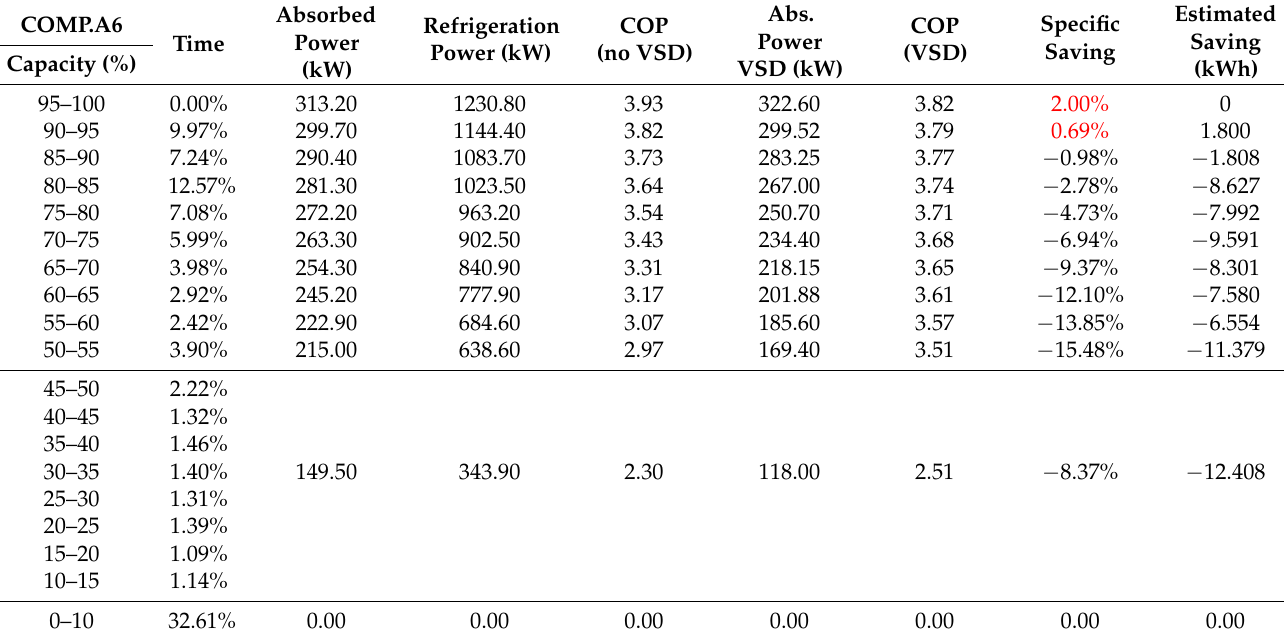
Table 3. Energy saving results due to speed variation in compressor No.